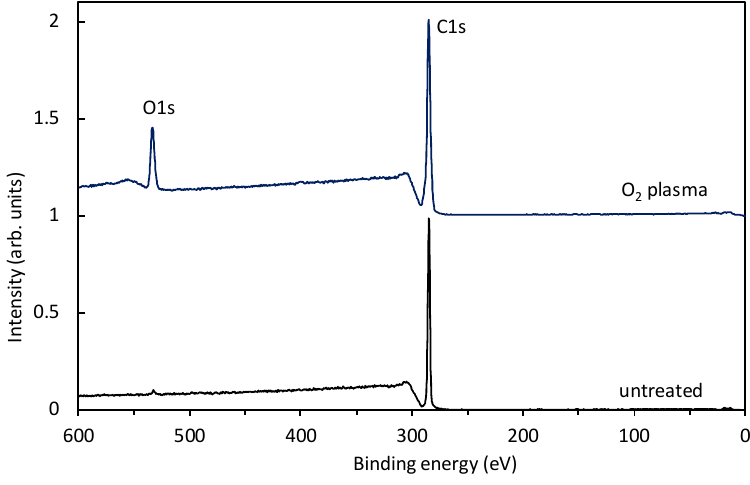
Figure 8. XPS survey spectra for an untreated and treated sample.